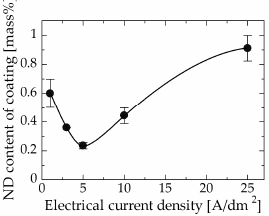
Figure 5. Relation between the current density and the ND content of the coating.